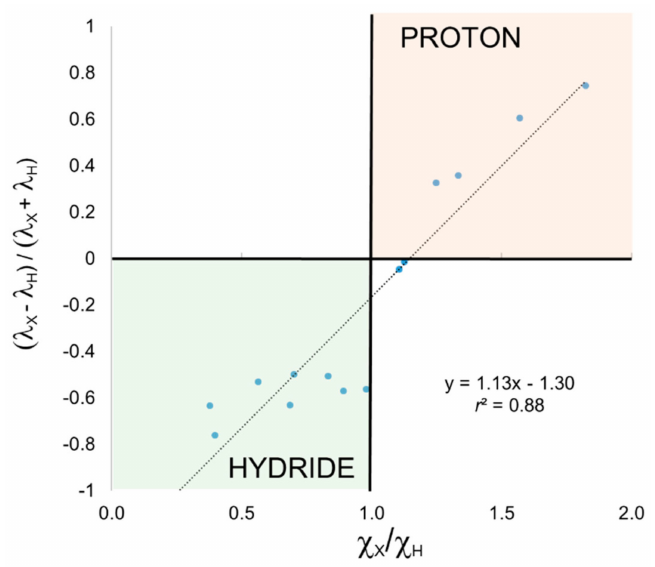
Figure 3. Relative occupation of frontier EFOs versus electronegativity ratio for the XH n set and OS assignment using EOS